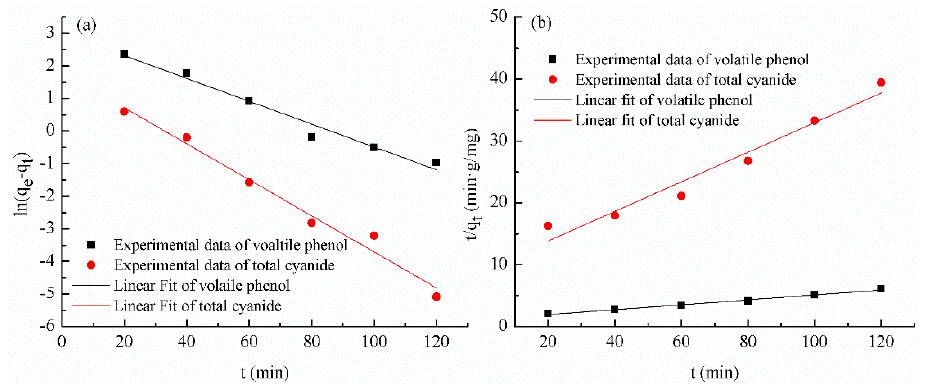
Figure 7. ( a ) Pseudo-first-order and ( b ) pseudo-second-order adsorption kinetics for volatile phenol and total cyanide adsorption onto SBAC. Table 4. Parameters of kinetic modeling of the adsorption of volatile phenol and total cyanide onto SBAC.